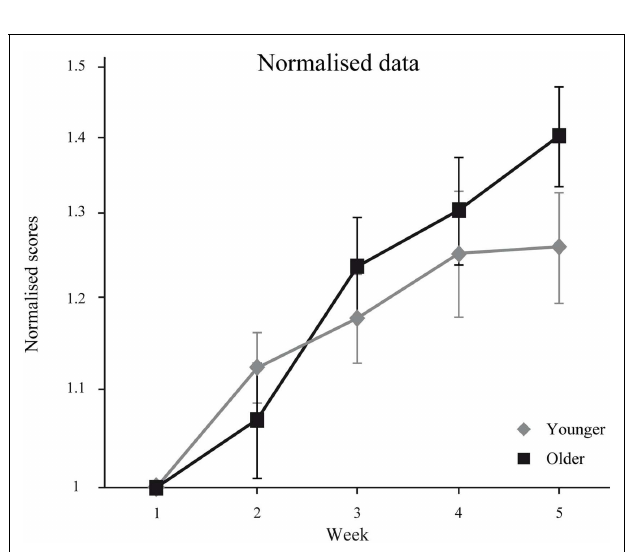
FIGURE 4 |Twenty younger and 20 older adults speed thresholds ( ± SEM) for five consecutive weeks .